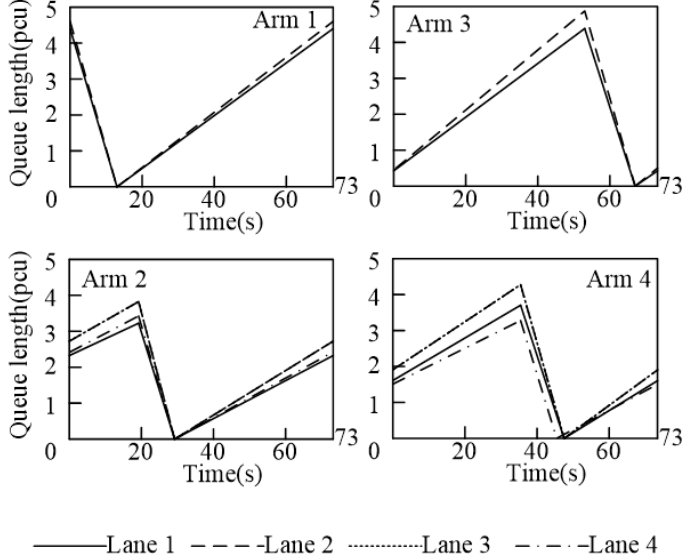
Figure 8. Queue length (in pcu) against time (from start to end of a signal cycle in seconds) from the optimized traffic signal settings in off-peak period.